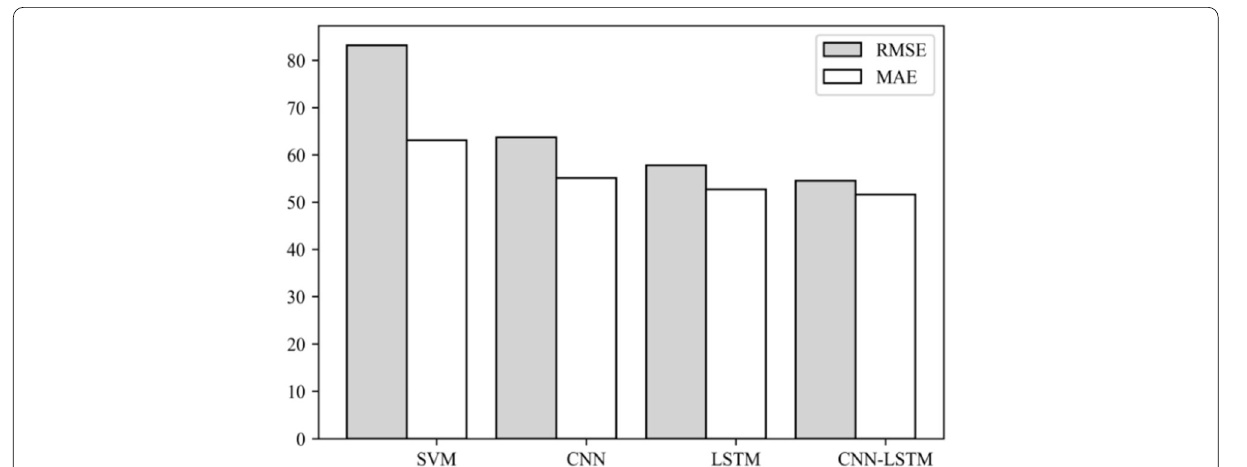
Figure 8 The modelling results of different parameters based on feature extraction